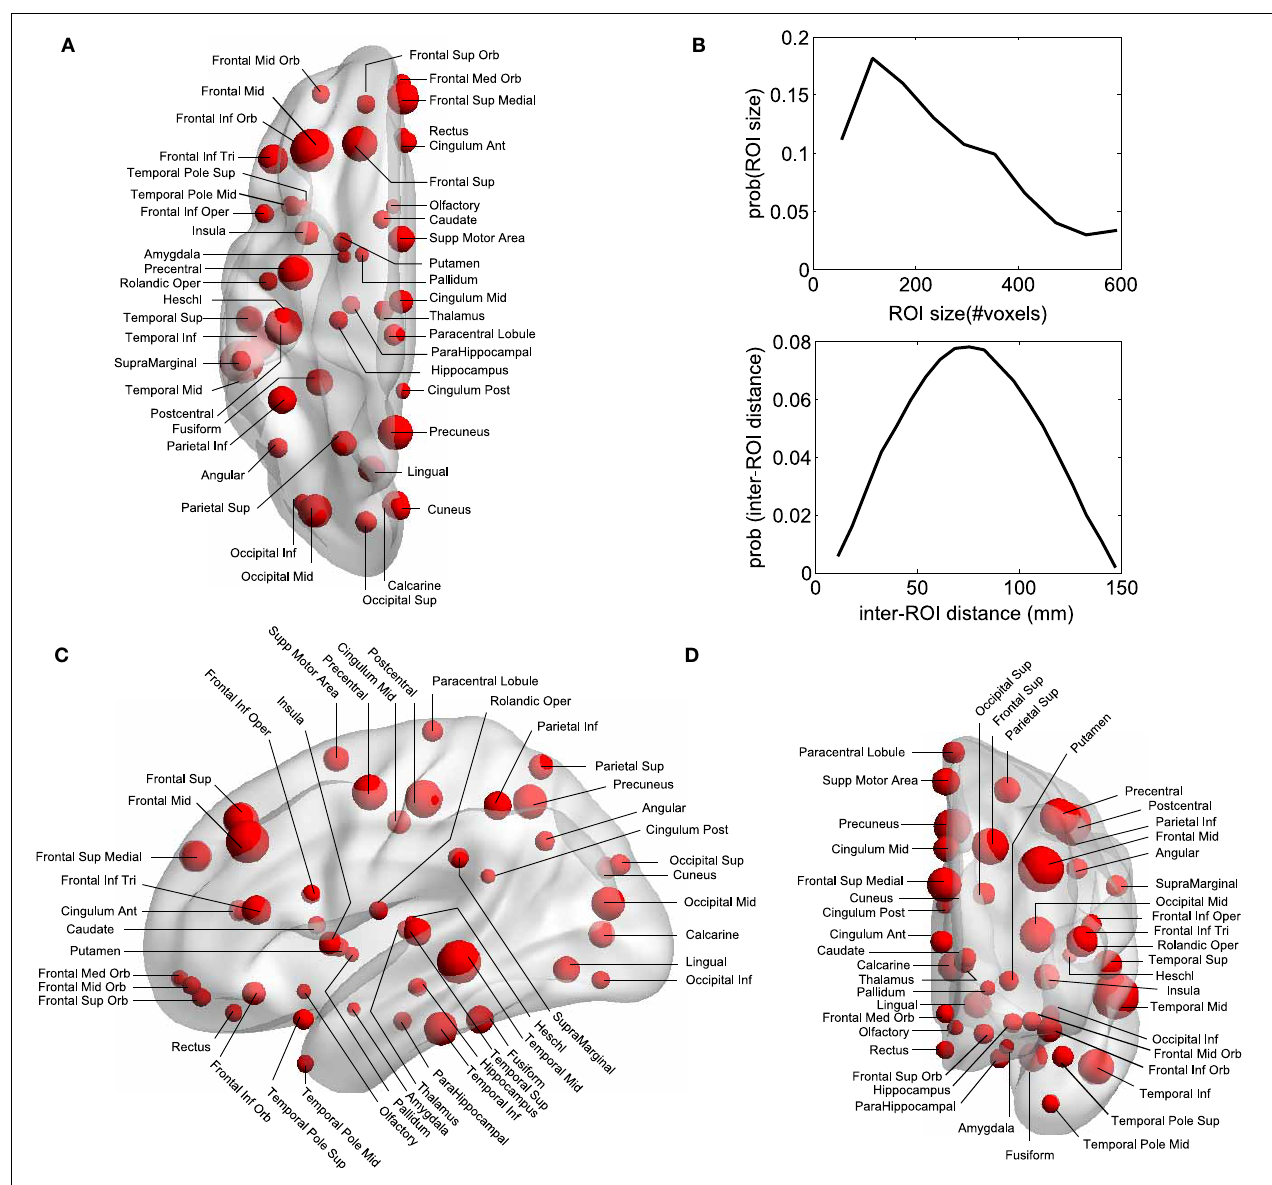
FIGURE 1 | Anatomical Brain parcellation and Regions of Interest (ROI). (A) Axial, (C) Saggital, (D) Coronal views. Specific ROI are depicted with spheres with diameters proportional to the ROI size (i.e., the number of voxels). Notice that the atlas has both cortical and subcortical components. (B)